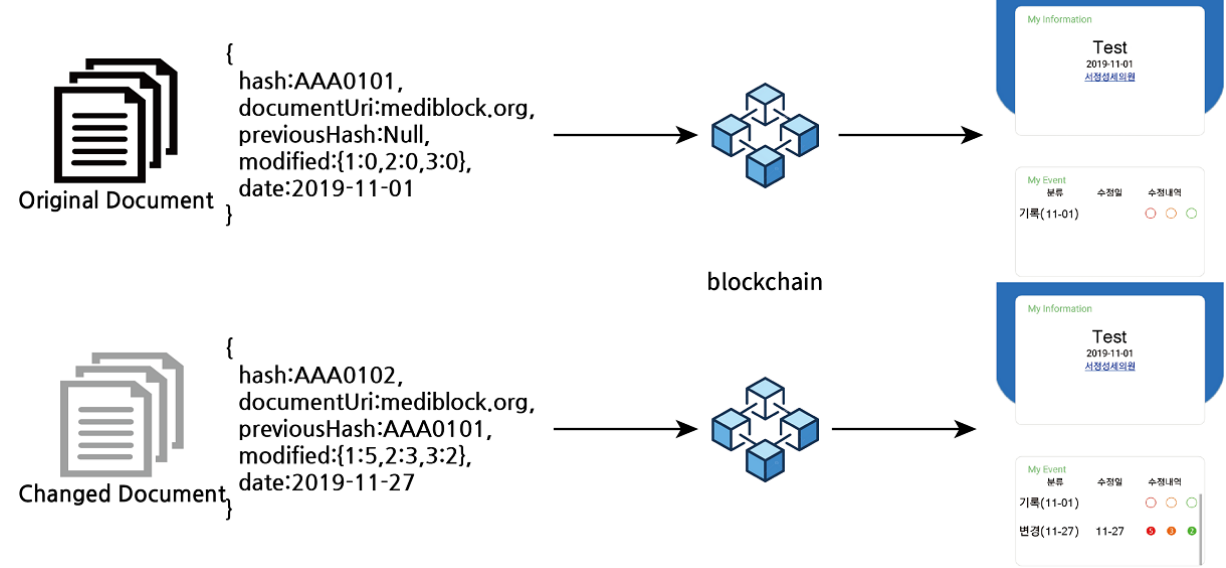
Figure 1. Structure of the medical document monitoring system.